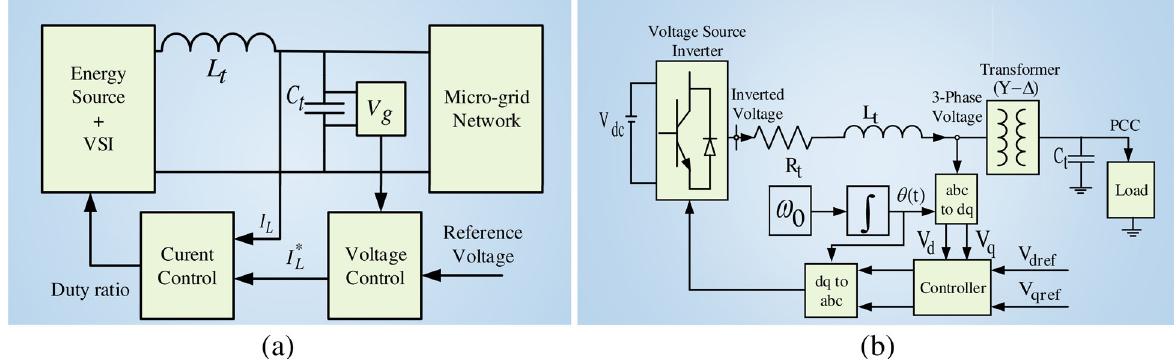
Fig. 13 ( a ) Closed-Loop Control Strategy in Single Phase Microgrid with VSI, ( b ) Closed-Loop Control Strategy in Three Phase Microgrid with VSI